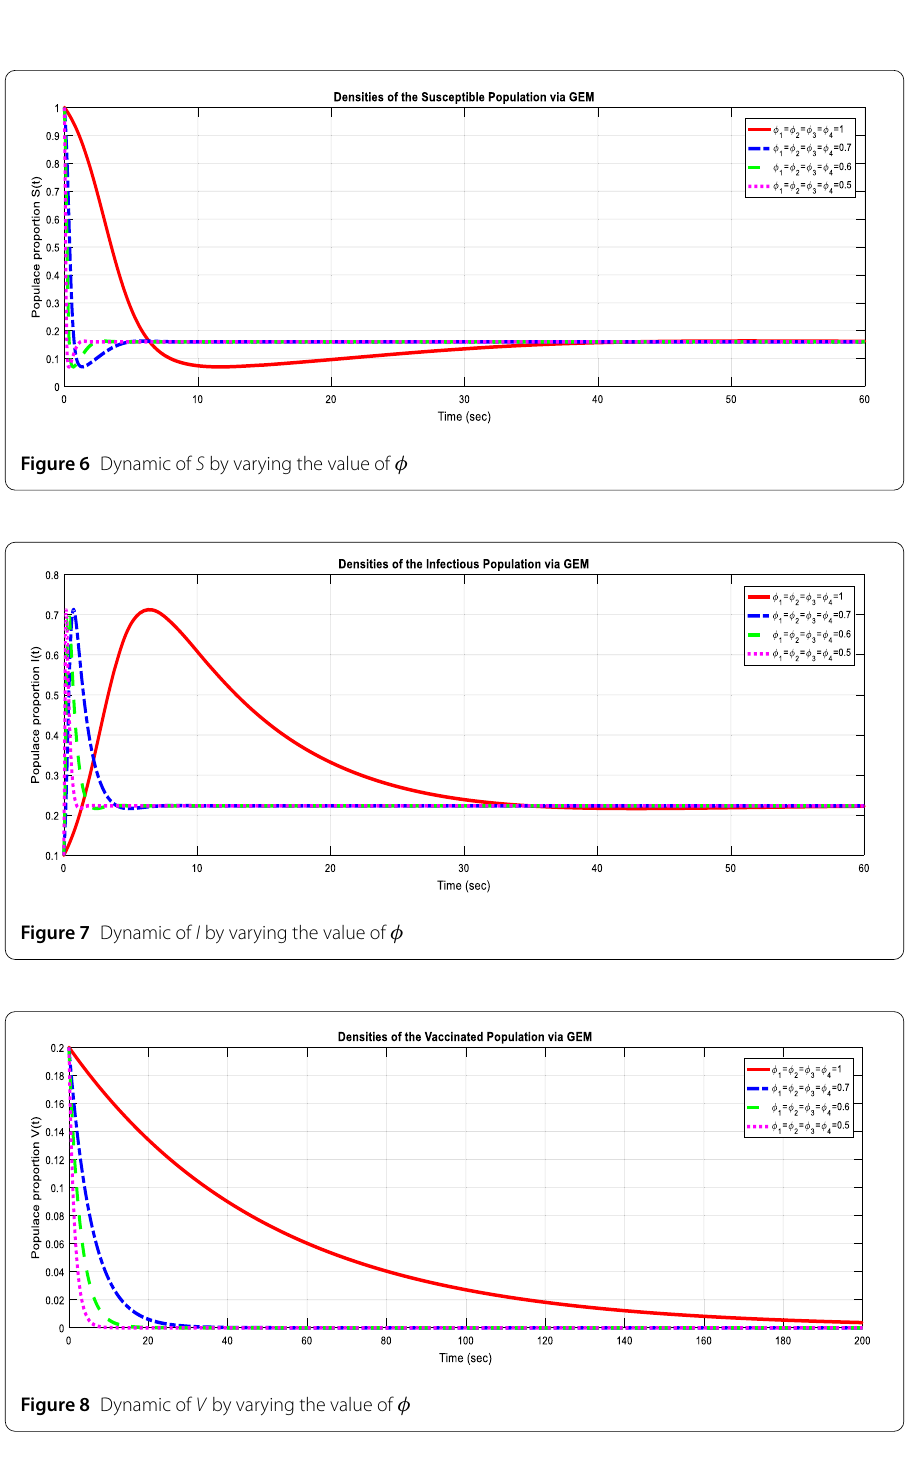
order is linked to the relaxation time, i.e., the time engaged to reach equilibrium. The chaotic comportment of the system when the total order of the system is less than four is delineated. A comparison among the four diverse values of non-integer order is shown in Figs. 2–33. For all cases, the ailment evolves to the disease-free and endemic equilibrium points. Figures 2–33 illustrate that the model gradually tends towards the steady state for different φ